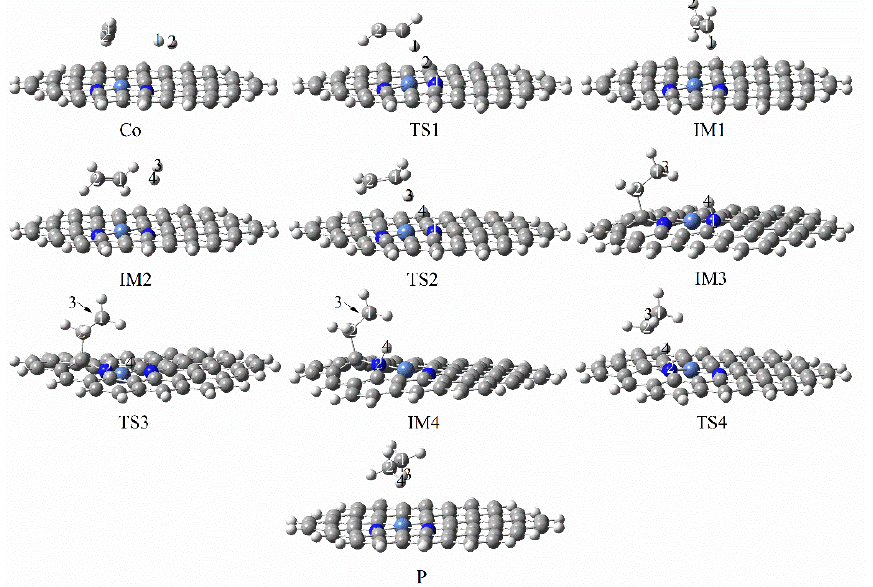
Figure 11. Optimal reaction pathway for acetylene hydrogenation catalyzed by graphene-NiN 2 (C) catalyst.